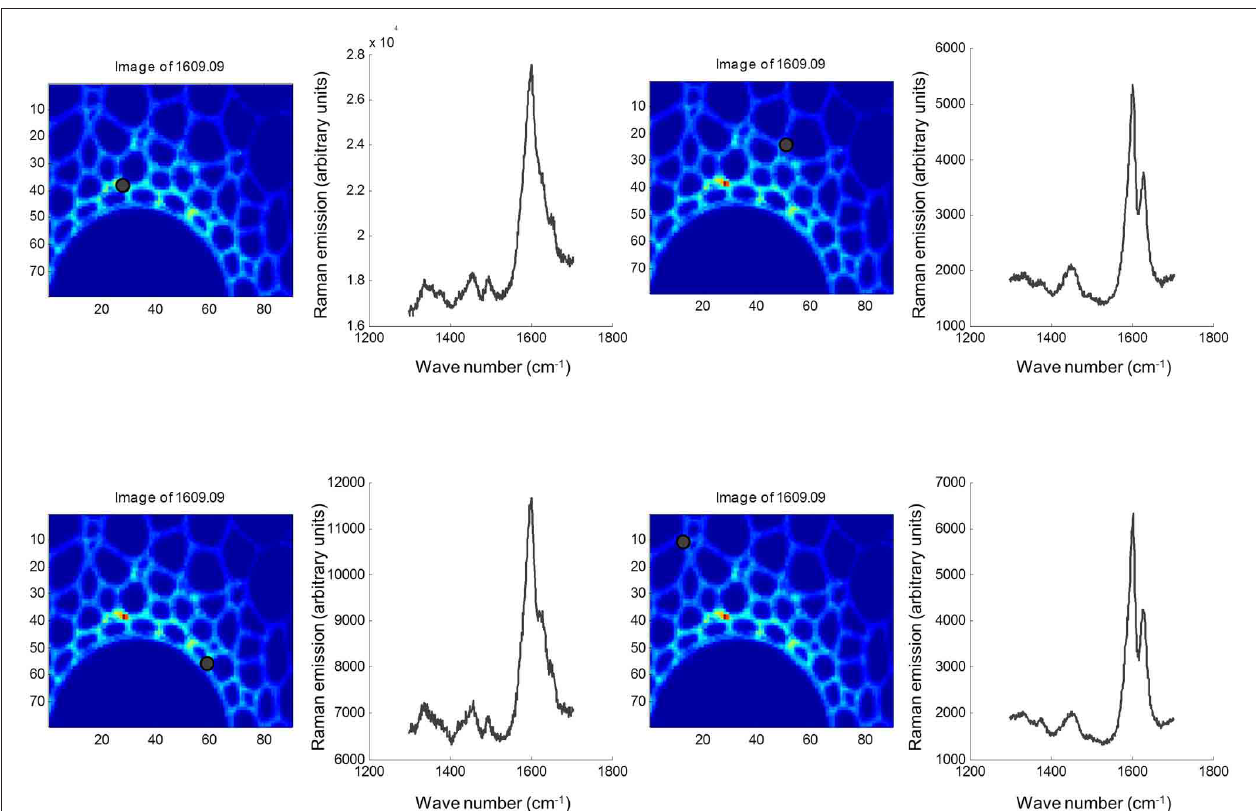
FIGURE 1 | Raman spectra at four locations in sections of mature maize stem internode. Sections were fixed in glutaraldehyde, cut to a thickness of 2 μ m and mounted on silicon slides (Bruker, Coventry, UK). Raman point spectra from 1300 to 1704cm − 1 were acquired using a Renishaw inVia Raman micro-spectrophotometer at × 50 magnification in